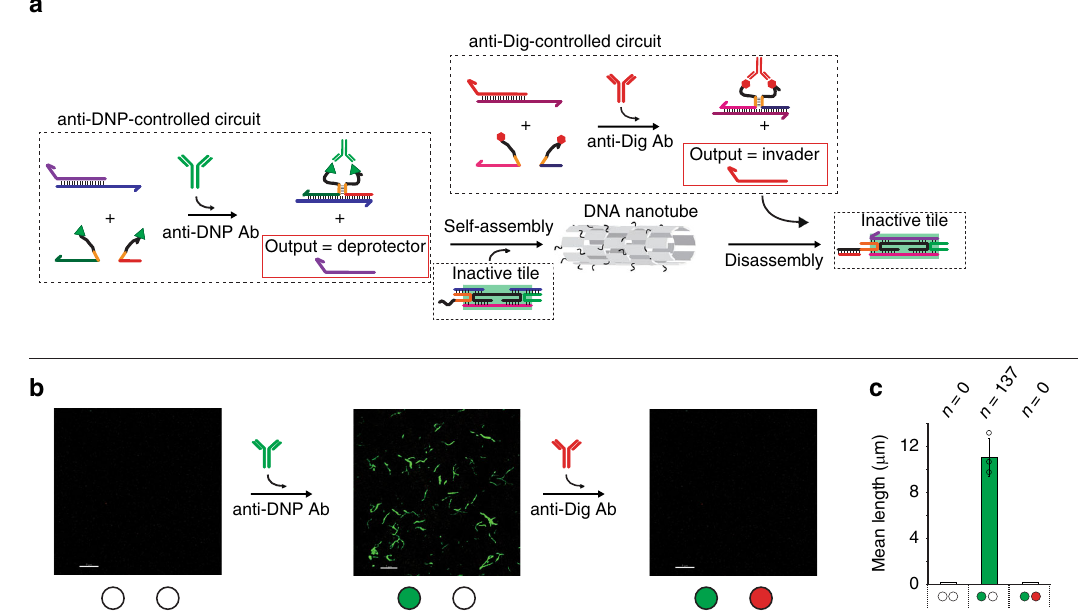
Fig. 4 Assembly/disassembly of antibody-controlled DNA nanostructures. We have employed here tiles modi fi ed to include a single-stranded overhang, or toehold (black domain on the 5 ′ end of the yellow strand) 18,19 which will be exposed on the external surface of the nanotube. An invader strand can thus bind to the toehold and displace one of the inter-tile bonds, causing the nanotubes to disassemble. a We have re-engineered two orthogonal antibody- controlled DNA circuits that respond to the presence of two different antibodies (anti-DNP and anti-Dig) and release two different outputs (a deprotector strand, to trigger self-assembly and an invader strand, to trigger disassembly). b Fluorescence confocal microscopy images of nanotubes in the absence of both antibodies (left), after addition of anti-DNP antibody (300 nM) (center) and after the addition of anti-Dig antibody (300 nM) (right). c Histograms of nanotube length (mean length) measured from fl uorescence microscopy images. In this panel the bars corresponding to mean length = 0 where no nanotubes are observed are shown as white bars for a matter of clarity. The experiments shown in this fi gure were performed in 1 × TAE, 12.5 mM MgCl 2 at pH 8.0, 25 °C. Nanotubes self-assembly was carried out in the presence of both the anti-DNP and anti-Dig DNA circuits (target duplex, 220 nM and equimolar concentration of the antigen-conjugated input-strands, 440 nM) and at a fi xed concentration of the inactive tile (200 nM). The experimental values represent averages of three separate measurements and the error bars re fl ect the standard deviations. Scale bars for all microscope images, 5 µ